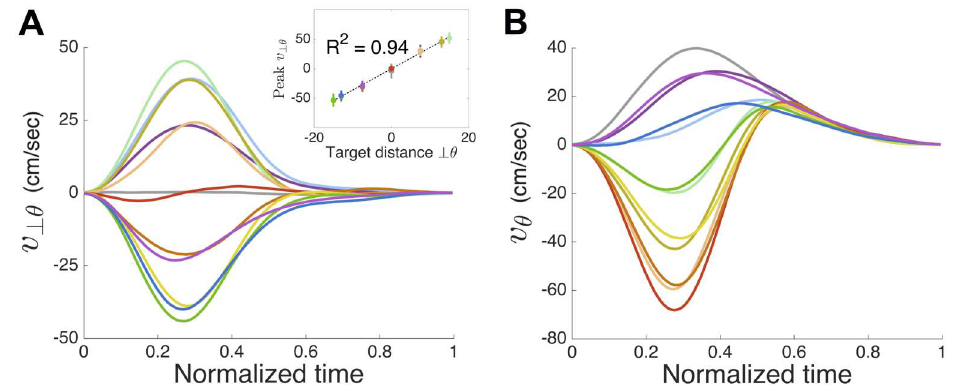
Fig 6. Timing of the velocity peak in Experiment 1. (A) Velocity componentperpendicular to the visibility modulation direction( θ ) againstnormalized time for the 12 directions of movement (colors as in Fig 4A). Inset shows peak speedagainst distanceto target perpendicular to θ . (B) as (A) for the velocity componentin the visibilityof modulation